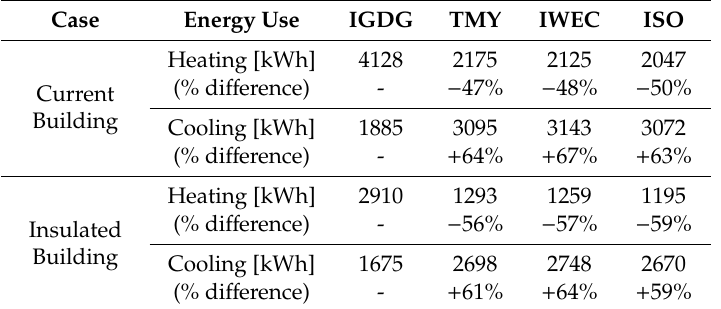
Table 8. Heating and cooling energy needs according to the di ff erent weather